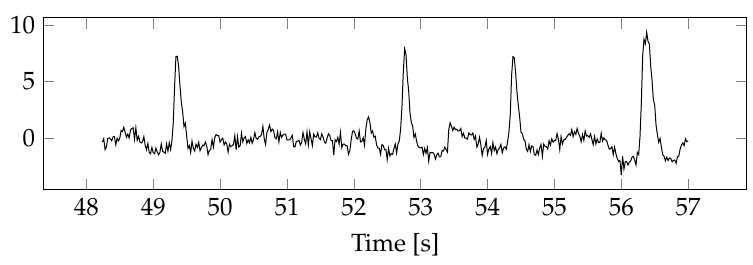
Figure 4. Excerpt from the ICA component containing eye